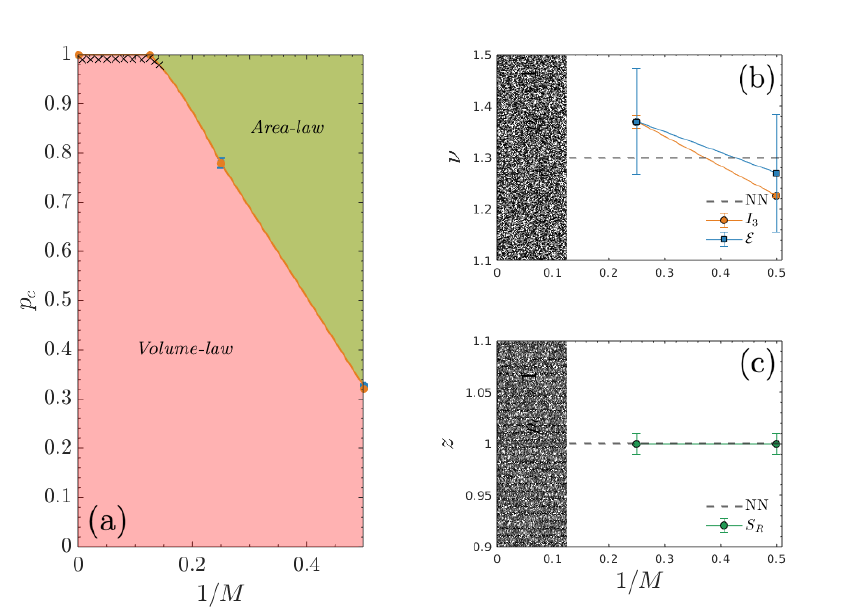
Figure 4: (a) The plot for the critical p as a function of the range of unitaries 1 / M . The p is extracted using both I and E for comaprision. The region marked ‘Volume- c 3 law’ shows a length dependent scaling of EE, whereas, in the region marked ‘Area- law’ EE scales independent of L . Our numerics show p compatible with 1 within c error bars for M > 6 (graphically shown as the crossed region in the above plot). Correspondingly, the behavior of critical exponents (b) ν obtained using I and E 3 and (c) z extracted using S , as a function of 1 / M is presented. The exponent ν r changes as 1 / M is changed whereas z = 1, within error bars. In both (b) and (c), the dotted line represents the nearest-neighbour values as obtained from the short ranged